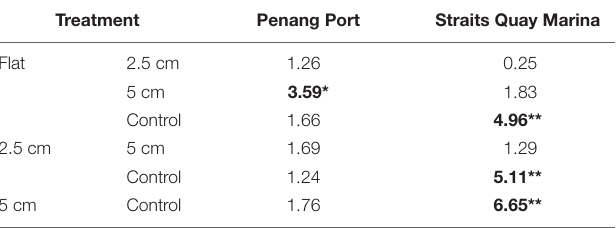
TABLE 7 | Results of Tukey pairwise comparison testing the effects of physical complexity on the recruited sessile assemblage at each site with the number of live seeded bivalves as